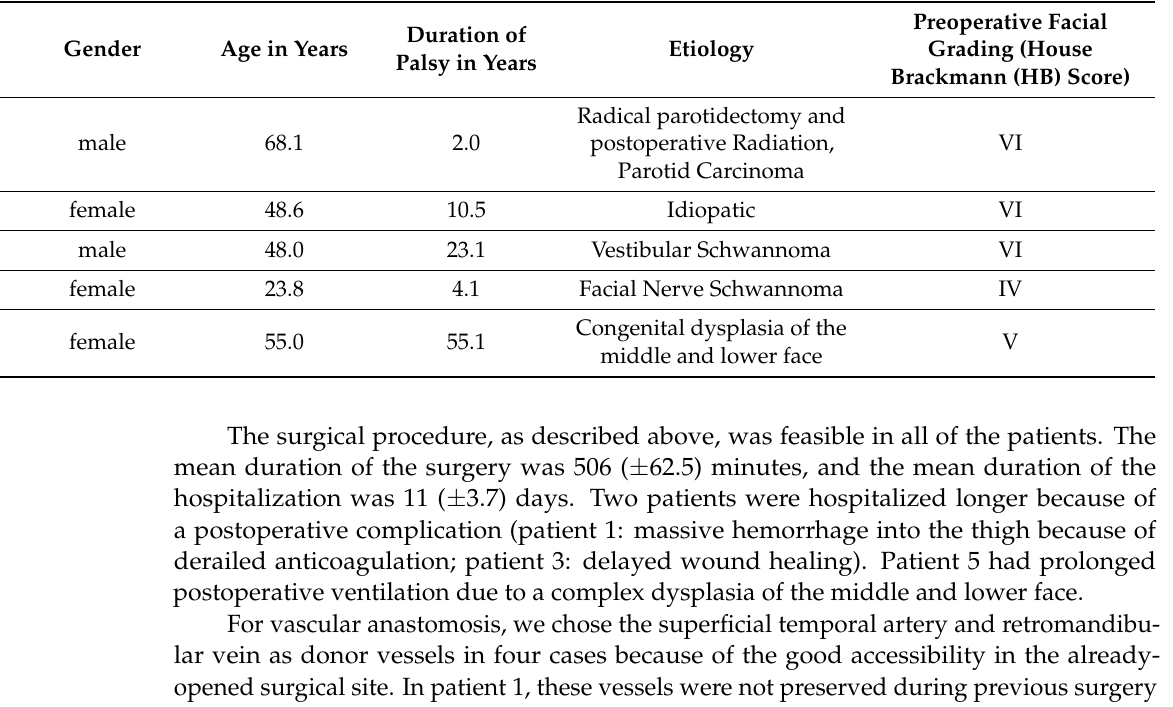
Table 1. Patients’ characteristics.